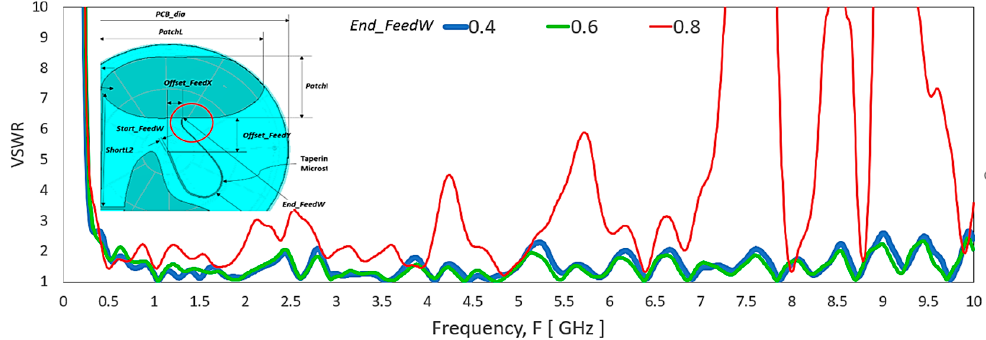
Figure 19. VSWR of the antenna by changing the width of the microstrip line, End_FeedW .